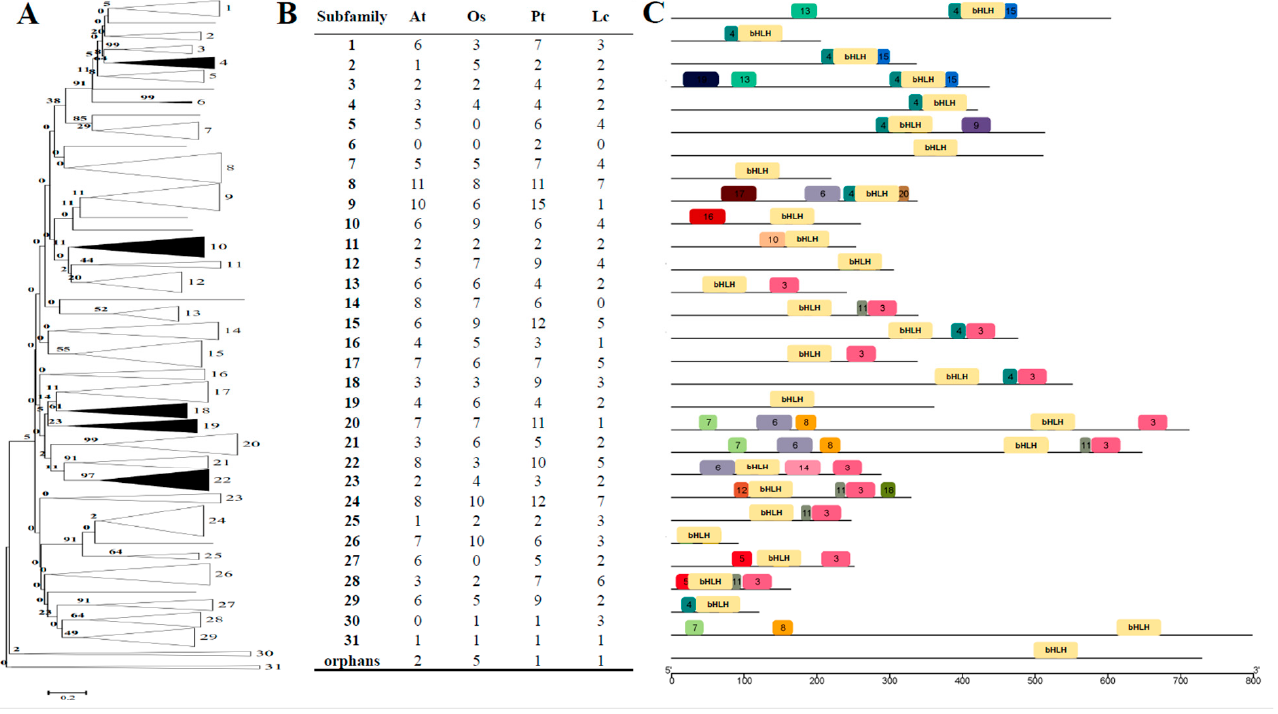
Figure 1. Phylogenetic tree of four species proteins. ( A ) The phylogenetic tree of four species; Liriodendron ( Lc ), Rice ( Os ), Arabidopsis ( At ), Poplar ( Pt ). The branches with a bootstrap value greater than 50 were represented by black triangles, while those with a bootstrap value less than 50 were represented by white triangles, which are divided into 31 subfamilies. ( B ) Summary of each group plant-species member representation in phylogeny analysis, plant species, ( At ) Arabidopsis, ( Os ) Rice, ( Pt ) Poplar, and ( Lc ) Liriodendron, group presentation denoted relative to their group marked as subfamily. Orphan genes are shown in the bottom column denoted orphans. ( C ) The motif patterns of Lc bHLH subfamilies, showing the bHLH domain present in all protein sequence analysed and other